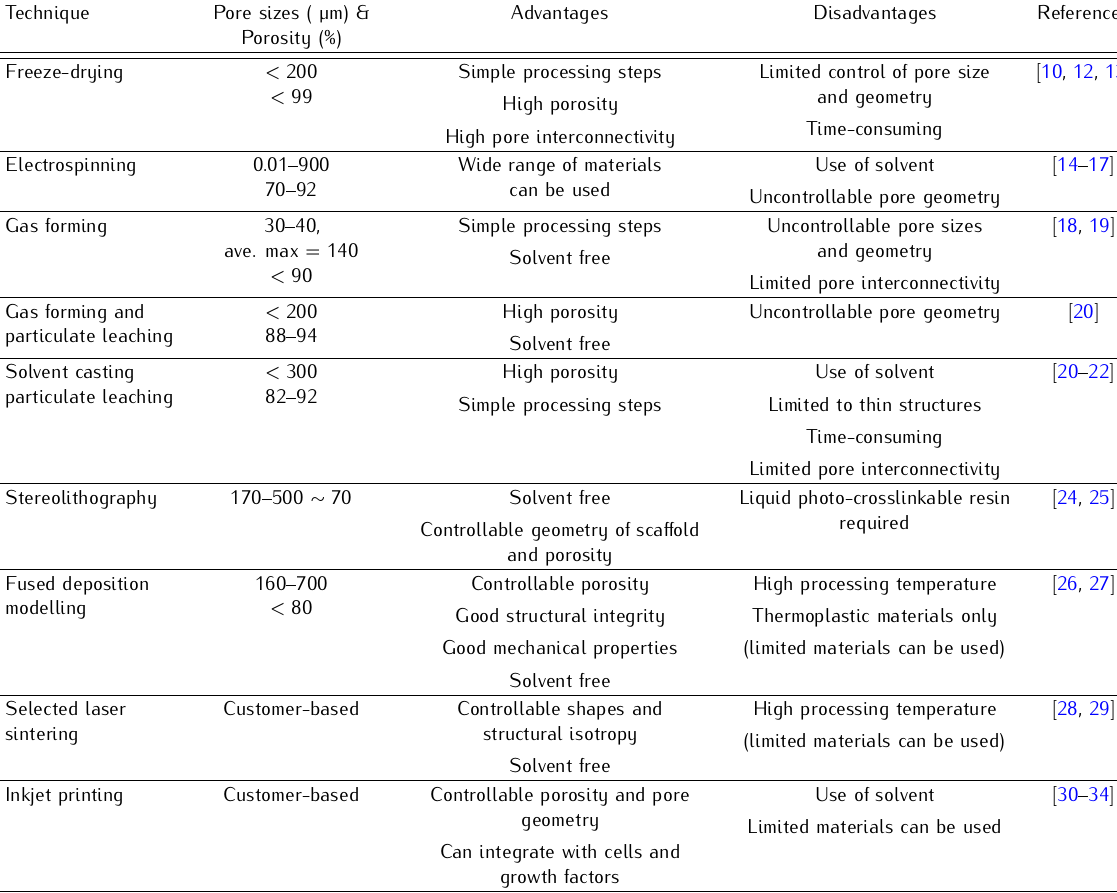
Table 1. Comparison of the main fabrication techniques used for tissue engineering [10, 12–22, 24–34].